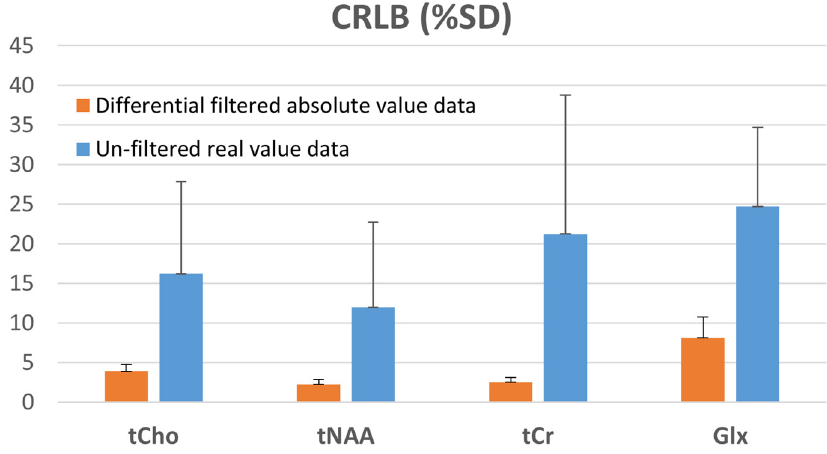
Figure 6. The LCModel quantitative analysis on the original data and the differential filtered data.